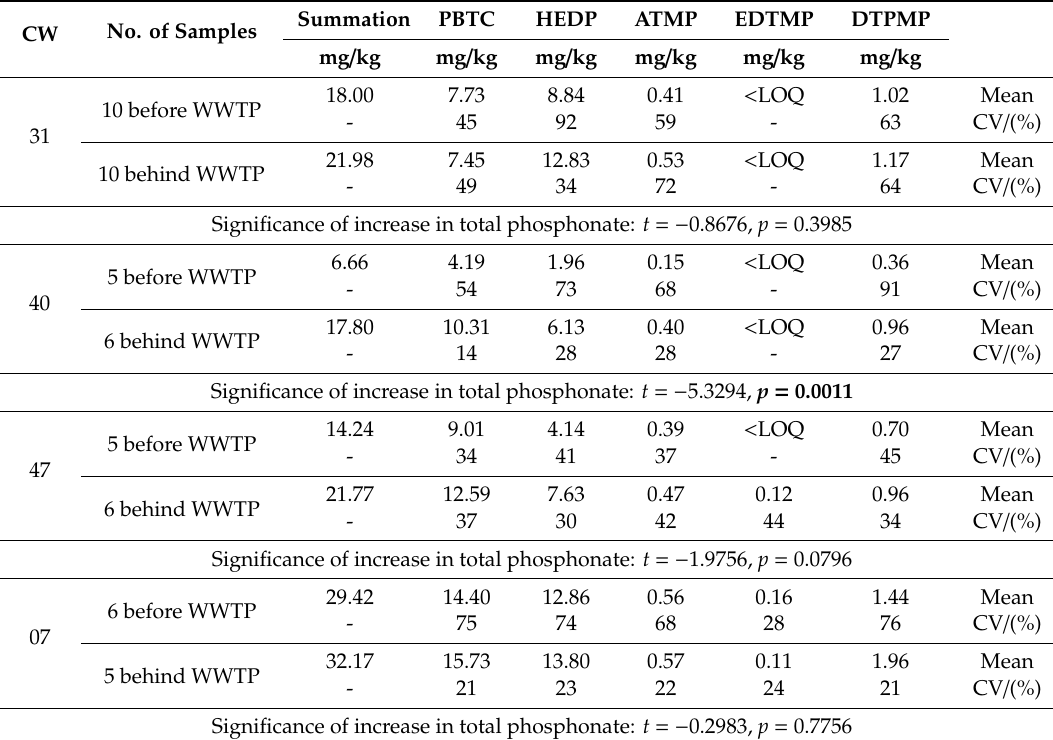
Table A4. Mean concentrations and coe ffi cients of variation (CV) of individually quantified random sediment samples taken at di ff erent locations in